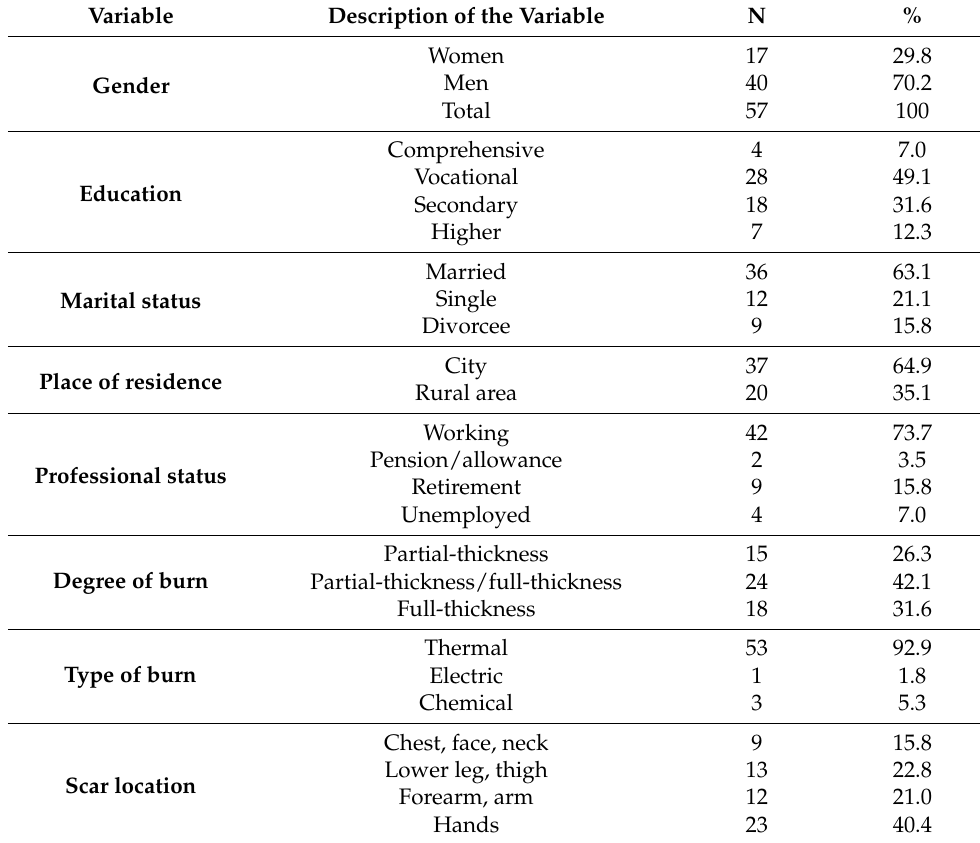
Table 1. General characteristics of the subjects in terms of sociodemographic and clinical variables.